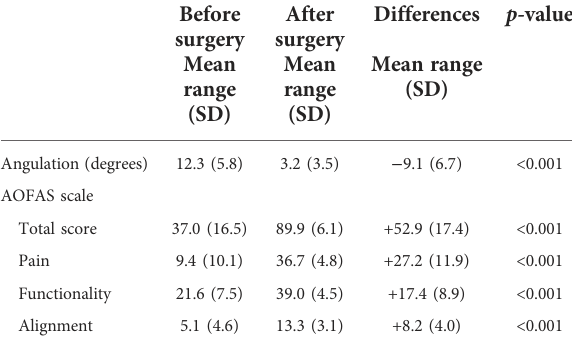
TABLE 1 Comparison of results before and after surgery.